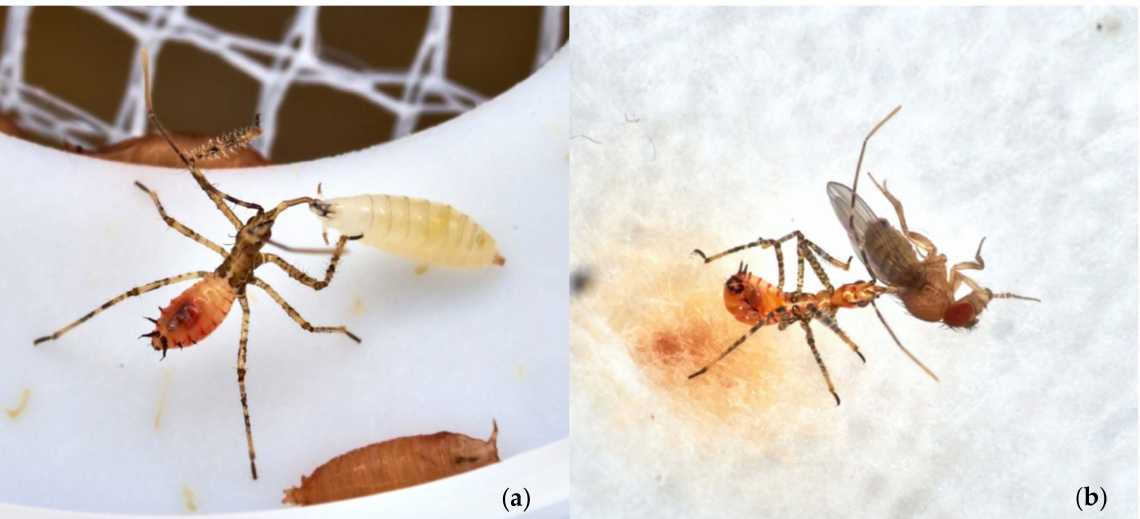
Figure 8. ( a ) LAB naiad feeding on Drosophila sp. larva; ( b ) LAB naiad feeding on D. melanogaster adult.